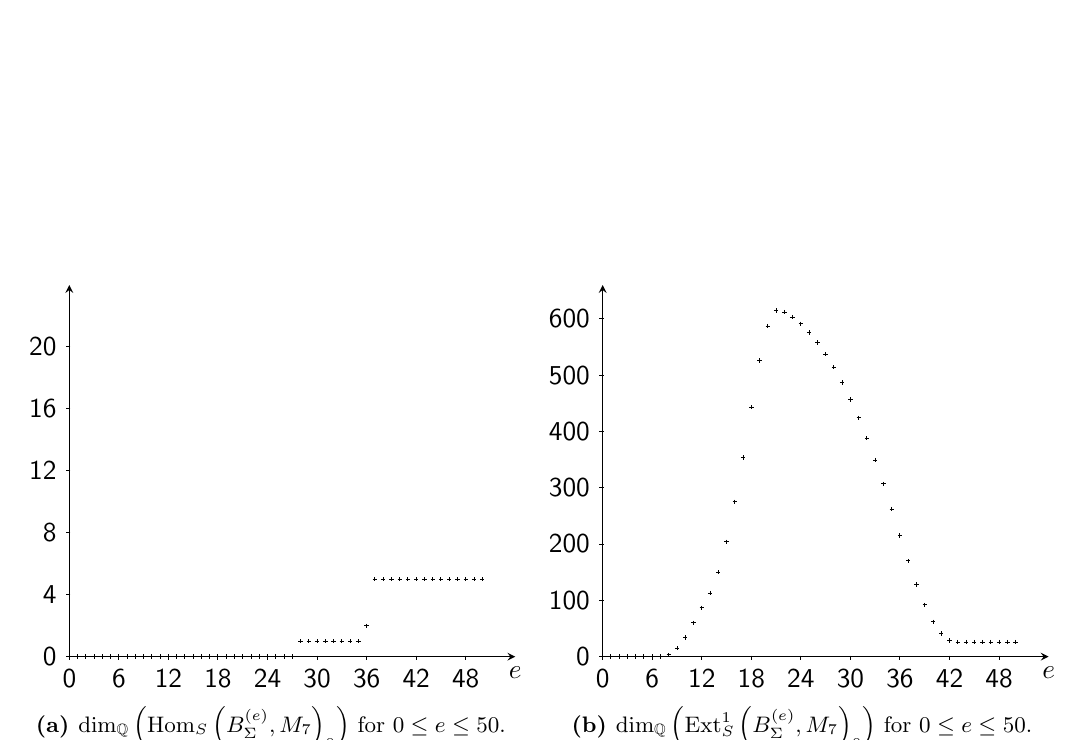
Figure 11. Computing the sheaf cohomologies of f M 6 with plesken .